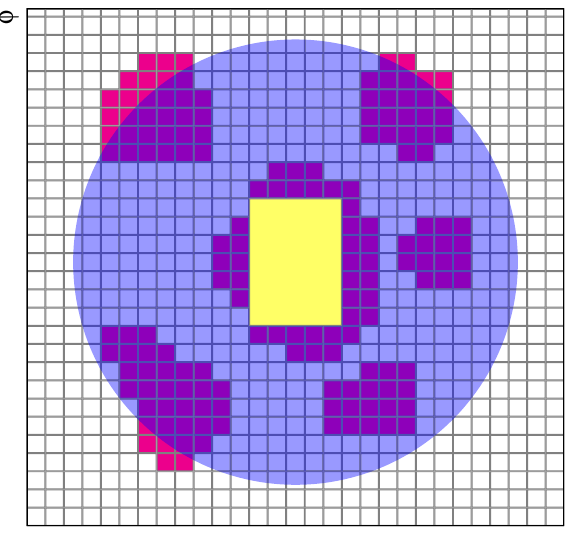
Fig. 10 Schema of the calorimeter isolation method: the grid repre- sents the second-layer calorimeter cells in the η and φ directions. The candidate electron is located in the centre of the purple circle represent- ing the isolation cone. All topological clusters, represented in red, for which the barycentres fall within the isolation cone are included in the computation of the isolation variable. The 5 × 7 cells (which cover an area of (cid:7)η × (cid:7)φ = 0 . 125 × 0 . 175) represented by the yellow rectangle correspond to the subtracted cells in the core subtraction method